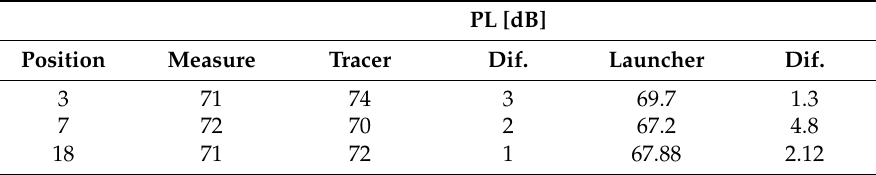
Figure 6. Comparison between the PDP measured at Position 18, simulated with the tracer and simulated with the launcher programmed in GPU.